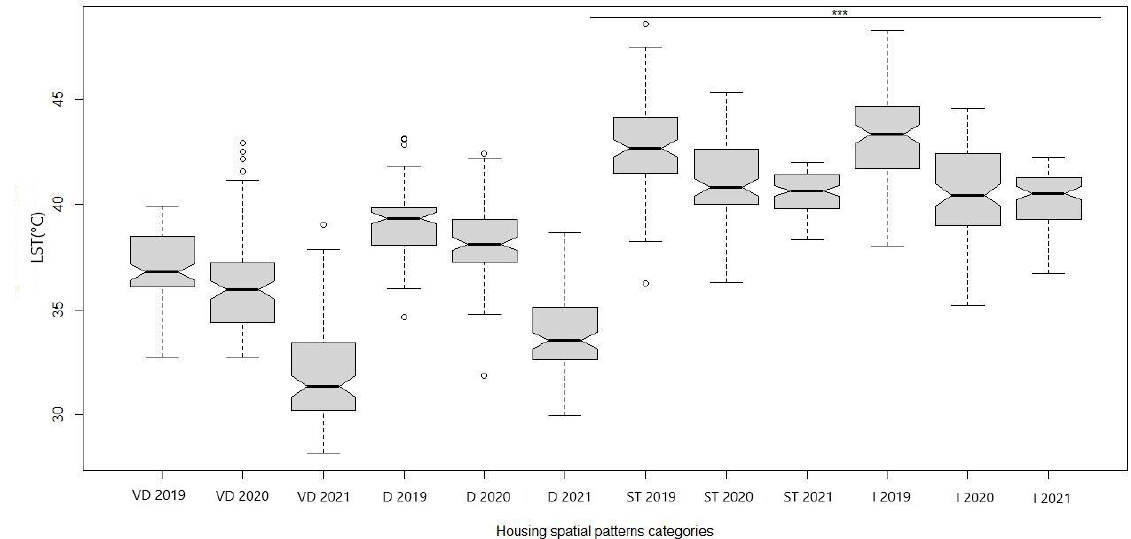
Figure 7. Average LST of the housing spatial patterns categories for the post-fire years of the study area evaluated by ANOVA statistical test ( p < 0.001***). The housing categories are: Very dense